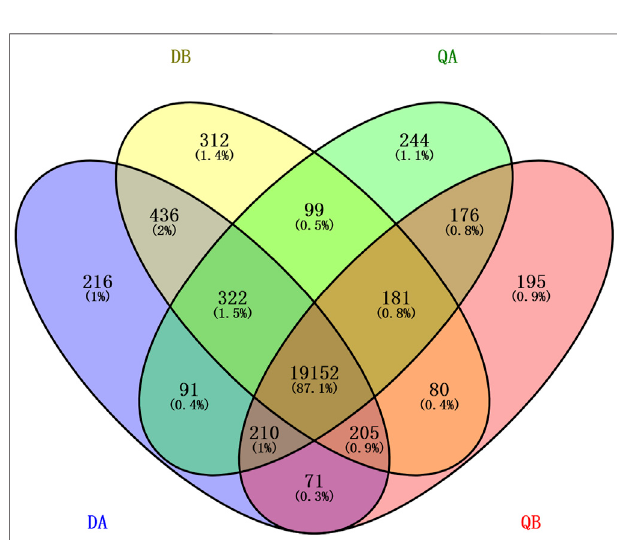
FIGURE 2 | Venn diagram showing the differentially expressed genes (DEGs) in the transgenic (ABJ01) and non-transgenic (9#) poplars grown in DaqingandQiqihar.DA:ABJ01fromDaqing,DB:9#fromDaqing;QA:ABJ01 from Qiqihar, QB: 9# from Qiqihar.